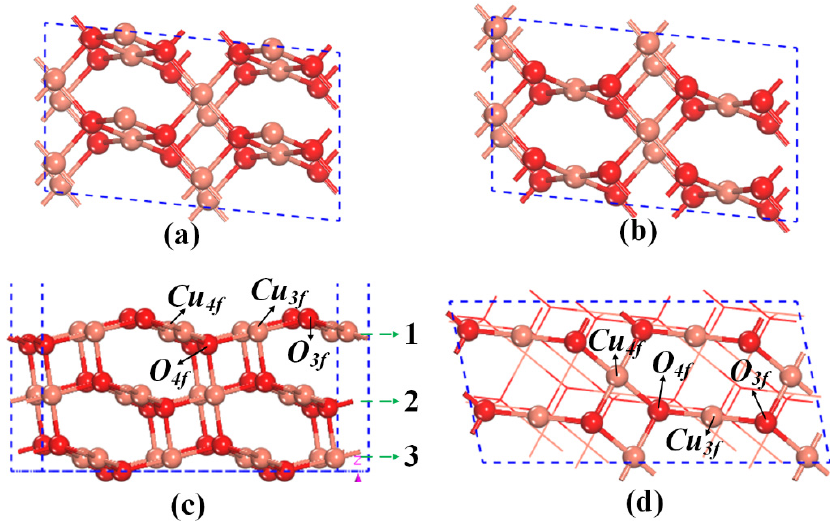
Figure 13. ( a ) O-terminated CuO(110) surface, ( b ) Cu-terminated CuO(110) surface, ( c ) the top view of a CuO(111) slab with different types of Cu and O atoms, and ( d ) the side view of a CuO(111) slab with different types of Cu and O atoms. The salmon pink spheres denote Cu atoms, and the red spheres denote O atoms, respectively.